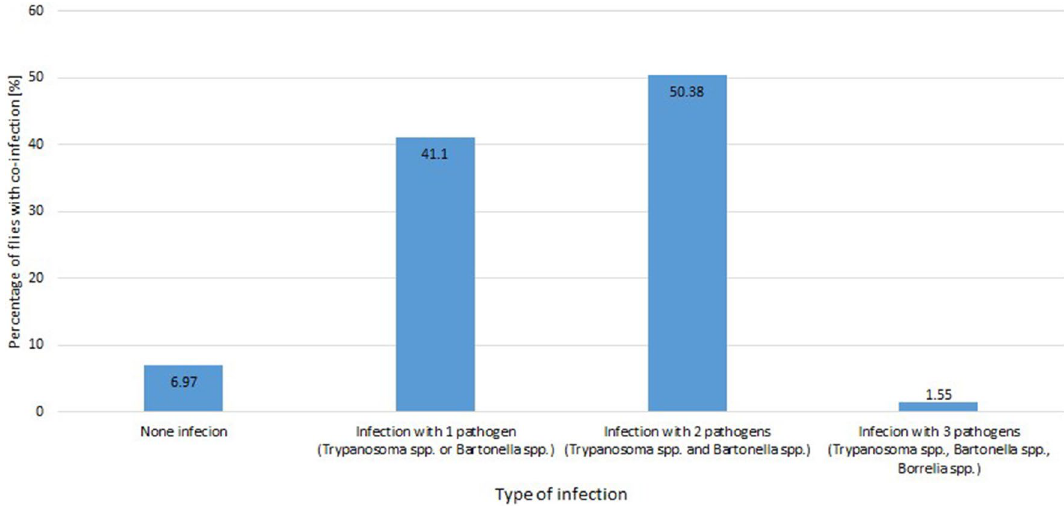
Figure 2. Total percentage of co-infection with Trypanosoma spp., Bartonella s pp. and Borrelia burgdorferi s.l. in flies collected from the studied areas. Variables Melophagus ovinus infected/non-infected by